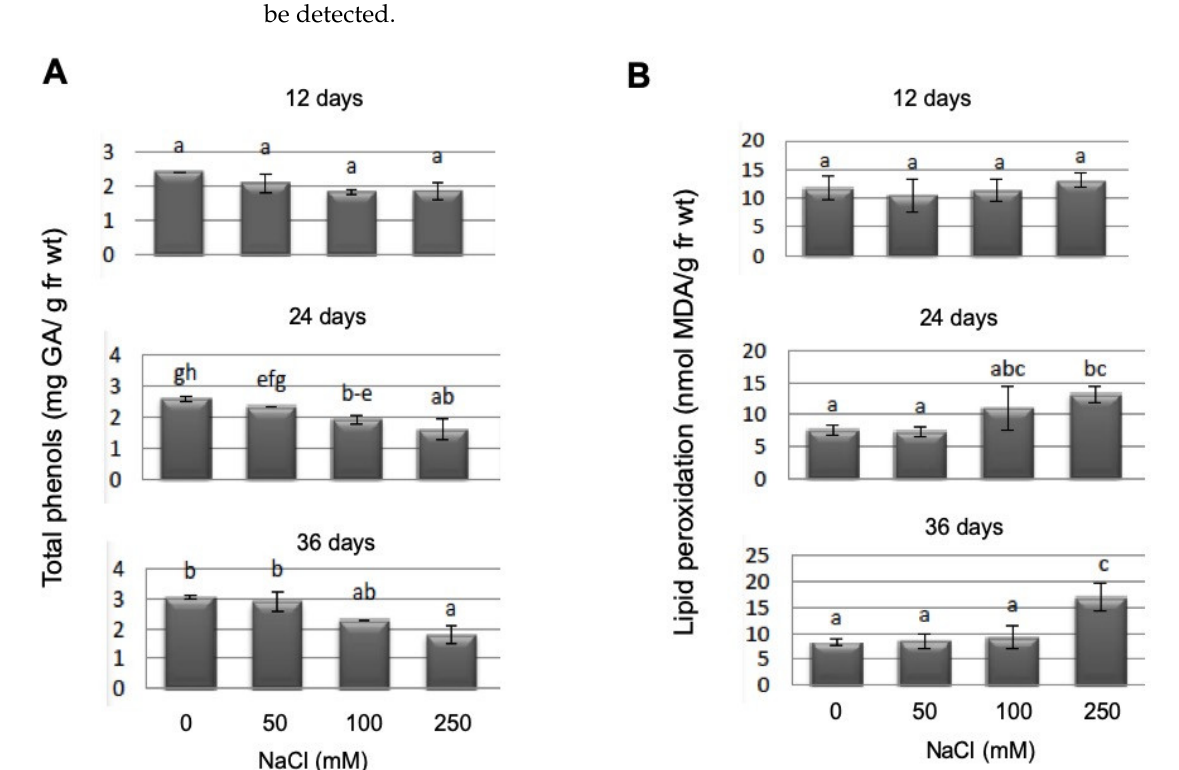
Figure 8. Total phenols determined as gallic acid equivalents ( A ) and lipid peroxidation as determined as MDA equivalents ( B ) determined in WT gametophores at different salt concentrations and at three different time points. Bars with different letters are significantly different at p < 0.05. Since the mutant lines did not show any difference in WT in their response to salt stress with these parameters, the complete dataset is displayed in the supplement.